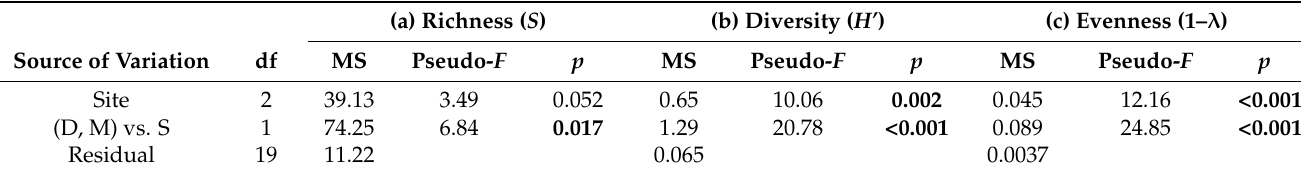
Table 1. PERANOVAs testing the effects of site (D = Danum, M = Maliau, S = SAFE) on (a) richness (S), (b) diversity (H’) and (c) evenness (1 − λ ) of lichen taxonomic groups, including planned comparisons between old growth (D, M) and logged (S) sites. Significant Monte Carlo p values are highlighted in bold.